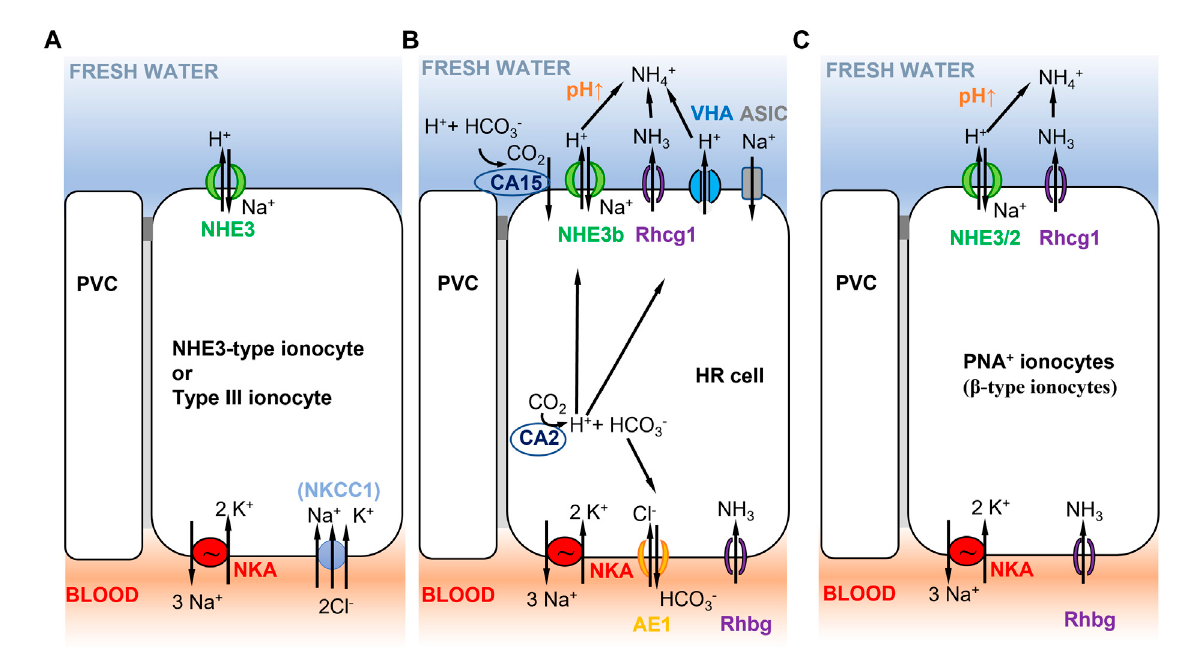
FIGURE 5 Selected ionocyte models consistent with Model 2 (Figure 1B) in different teleost fi sh species. (A) Tilapia type III ionocyte, and Japanese and European sea bass D. labrax NHE3-type cell. Type III ionocyte in tilapia involves apical NHE3 and basolateral NKA, and NKCC1 in fi sh that have been recently transferred to freshwater (Hiroi et al., 2005, 2008; Inokuchi et al., 2008). NHE-3 cells show similar characteristics and are present in gill lamellae of Japanese (Inokuchi et al., 2017) and European sea bass (Blondeau-Bidet et al., 2019). (B) zebra fi sh HR cell. Na + /NH 4 + exchange complex inzebra fi shHR cells (Hwang etal.,2011)with basolateralNKA(low expression, mainly ATP1a1a.5 and ATP1b1b paralogous genes, Liao etal., 2009),AE1( SLC4a1b ,LeeY.C.etal.,2011),andRhbg.HRcellsexpressapicalNHE3b,VHA(Yanetal.,2007),Rhcg1,andtheacid-sensitiveionchannel ASIC (ASIC4.2 in adults, Dymowska et al., 2015; ASIC4b in larvae, Zimmer et al., 2018). Cytoplasmic CA2 contributes to H + production that is apically excreted via NHE3b or VHA. Extracellular CA15 (or CA4-like) contributes to lower apical H + , resulting in increased pH that favors NHE3b activity. No NBC1 cotransporter has been reported in this cell type (Lee Y. C. et al., 2011). (C) Rainbow trout PNA + ionocyte. PNA + ionocyte model with apical NHE3/2 ( slc9a2 , slc9a3 ; Ivanis et al., 2008) and Rhcg1 coupled to basolateral